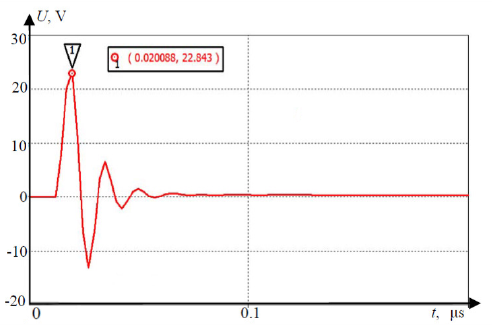
Figure 16. Electromagnetic disturbance example in the antenna-feeder path.